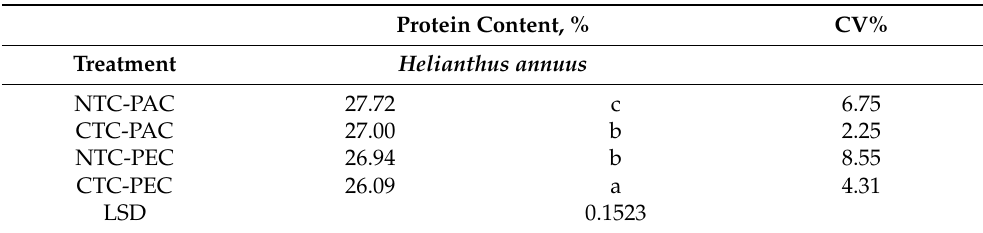
Table 4. Protein content (%) of the Helianthus annuus cultivation in the 4 different soil practice treatments in the second growing year.